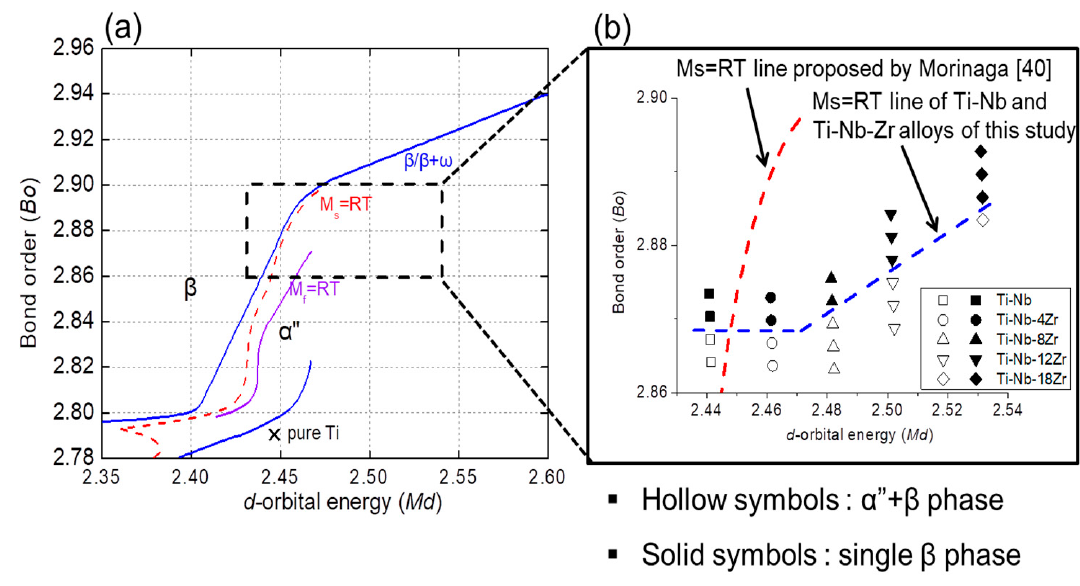
Figure 12. ( a ) Bo-Md map taken from Reference [41], and ( b ) newly constructed Ms line in this study.